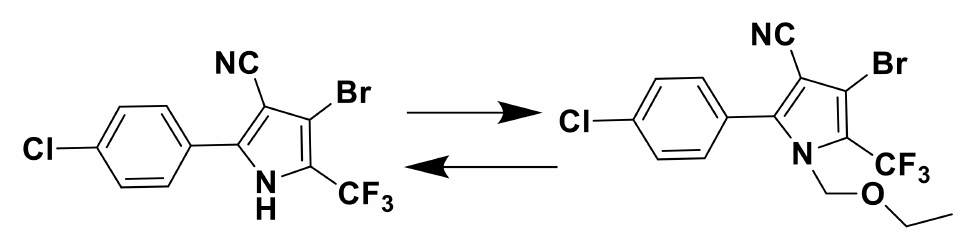
Figure 1. Chemical structure of tralopyril and